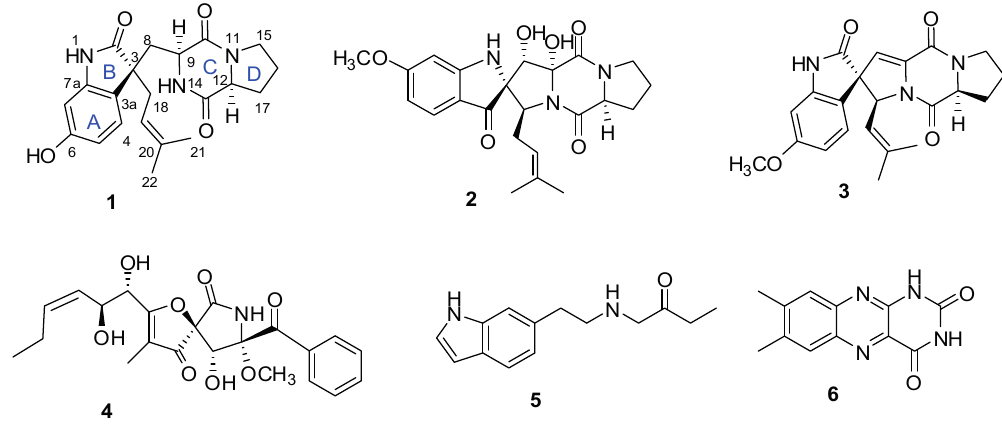
Figure 1. Structures of compounds 1 – 6